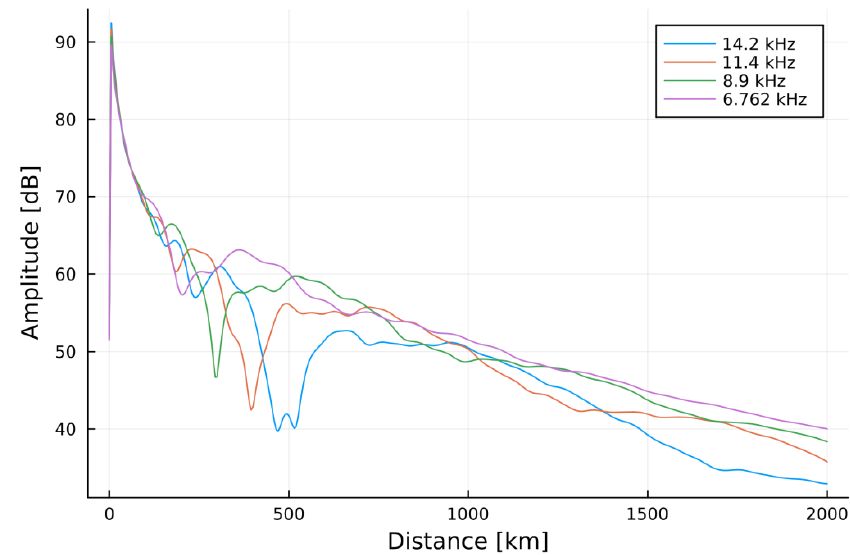
Figure 14. The LMP-simulated signal coverage along the 2000 km path for four VLF frequencies (amplitude in arbitrary units), corresponding—in accordance with Figure 4—to the emitter’s altitudes of 0, 15, 30, and 40 km.